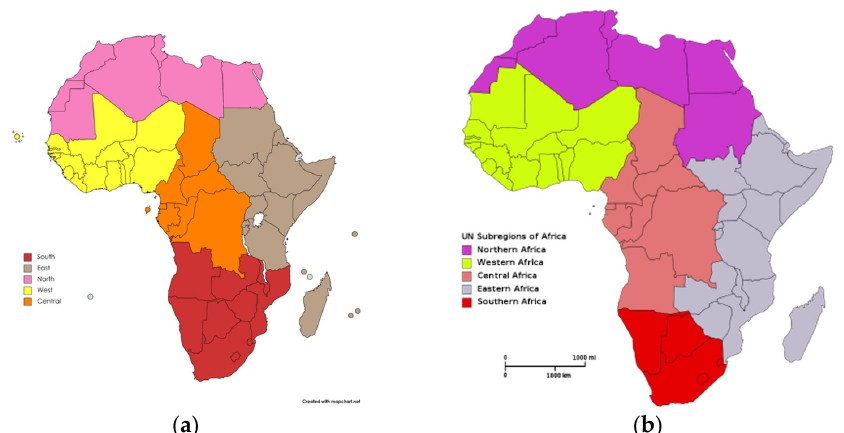
Figure 10. African Regions Classifications ( a ) African Union; ( b ) United Nations, Source: CC BY-SA 3.0, Available online: https://commons.wikimedia.org/w/index.php?curid=546265 (accessed on 14 July 2022).